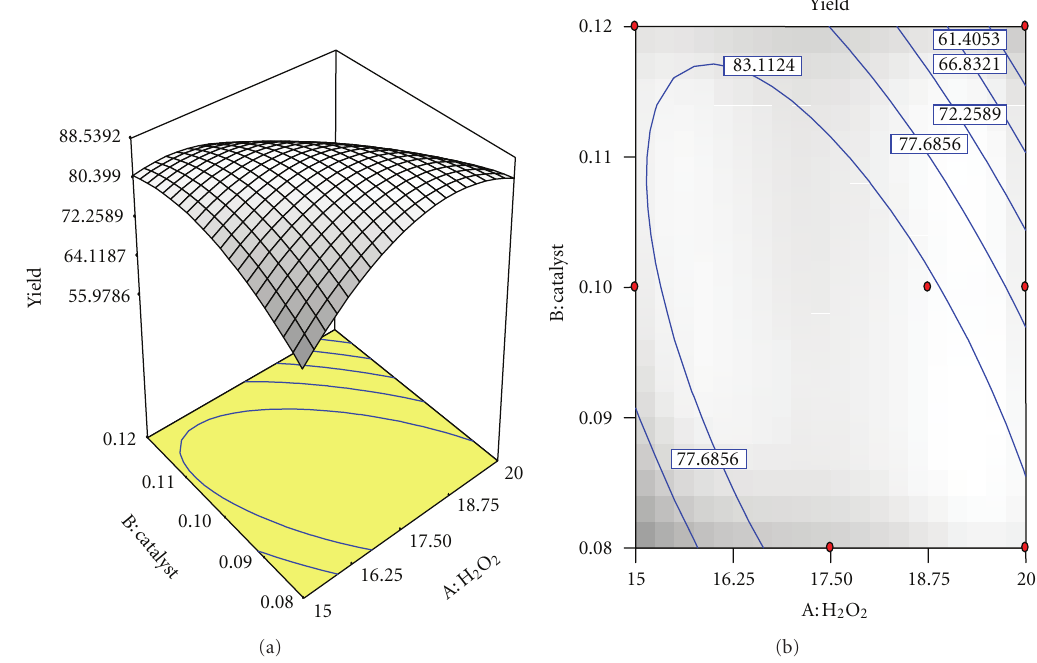
Figure 3: Response surface (a) and contour plots (b) for the e ff ect of the H 2 O 2 ( X 1 , μ L) and catalysts Novozym 435 ( X 2 , mg) on the yield% of